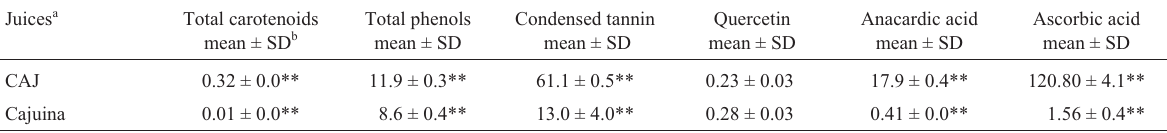
Table 1 - Chemical components of CAJ and of